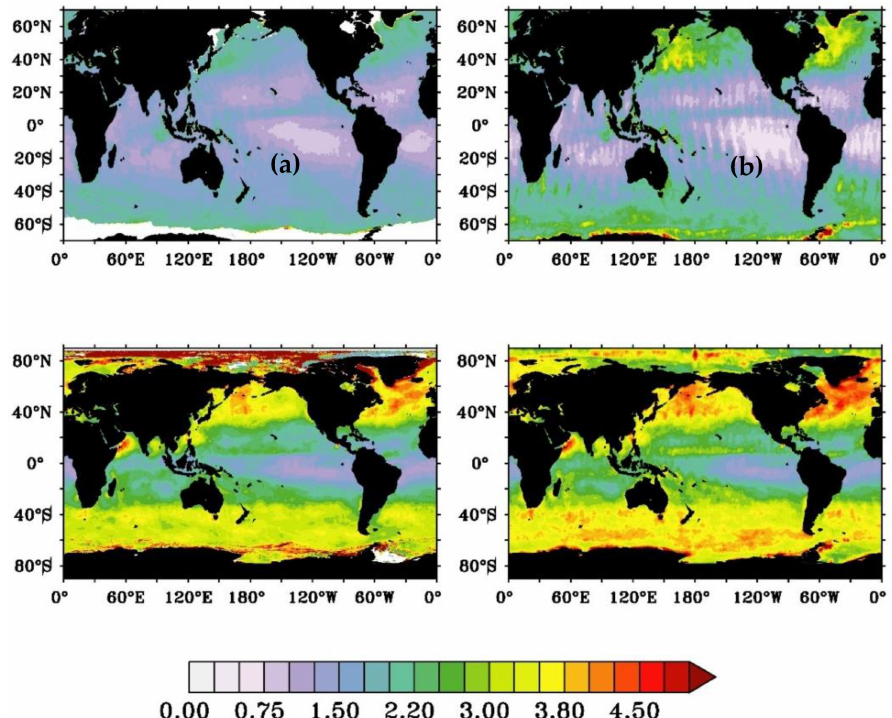
Figure 10. The spatial distribution of RMSE (top panel) and standard deviation (bottom panel) in wind speed (m/s) between daily CCMP winds and ( a ) Particle filter based reanalysed wind speed and ( b ) SCATSAT-1 L4AW wind speed during 2018.